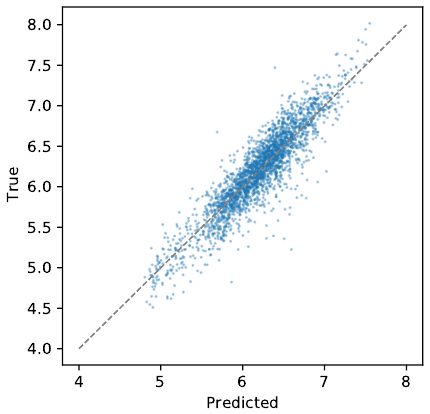
( GDP ) Figure 4. Scatter plot of the estimated and true log 10 values taken MVGNN+ALL as input features. (The GDP unit is 10 4